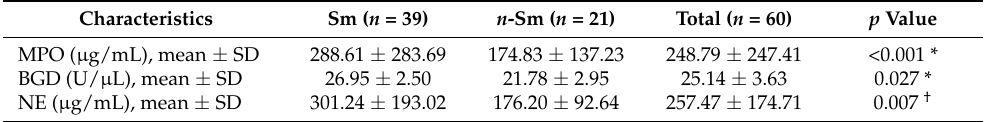
Table 3. Descriptive Statistics for Biochemical Parameters of Study Participants According to Smoking.